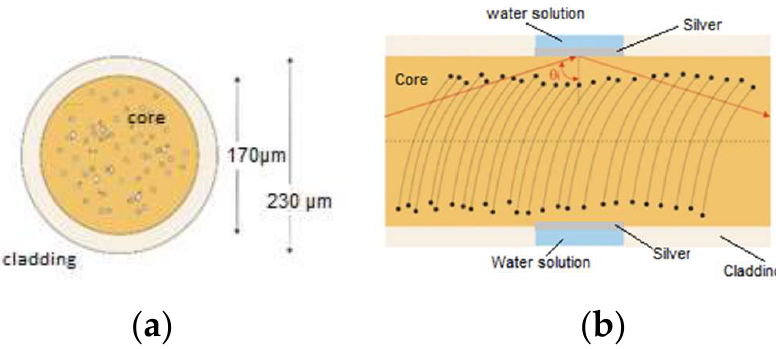
Figure 1. ( a ) LDF cross-section; ( b ) LDF lateral view with the portion of the sensing region.